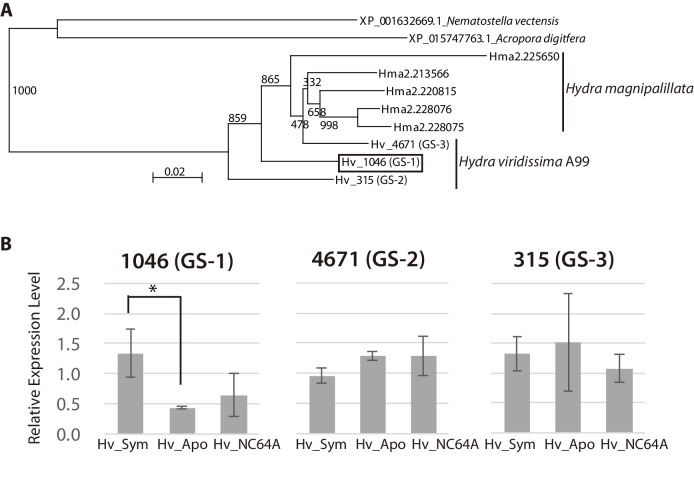
Glutamine synthetase (GS) genes in Cnidarians.(A) Phylogenetic tree of the GS gene of four species in Cnidarians. While anthozoans (Nematostella vectensis, Acropora digitifera) have a single GS gene, Hydra magnipappilata (Hma) has five genes and Hydra viridissima A99 has three genes, Hv_1046 (GS-1), Hv_315 (GS-2) and Hv_4671 (GS-3). (B) Average of relative expression level of the three GS genes in Hv_Sym, Hv_NC64A and Hv_Apo as determined by microarray analysis. Error bars indicate standard deviation. P-value of t-test, *<0.05.